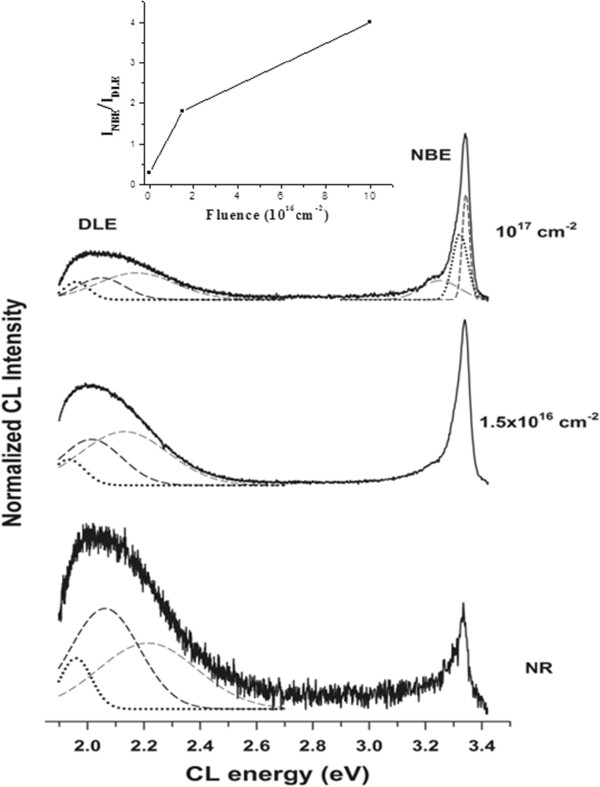
Normalized CL spectra collected on individual NWs. Unirradiated (NR) and irradiated areas with fluences of 1.5 × 1016 cm−2 and 1017 cm−2. An increase of the NBE emission with respect to the visible band as the irradiation fluence increases is observed (see the inset). Gaussian deconvolution bands are also shown.